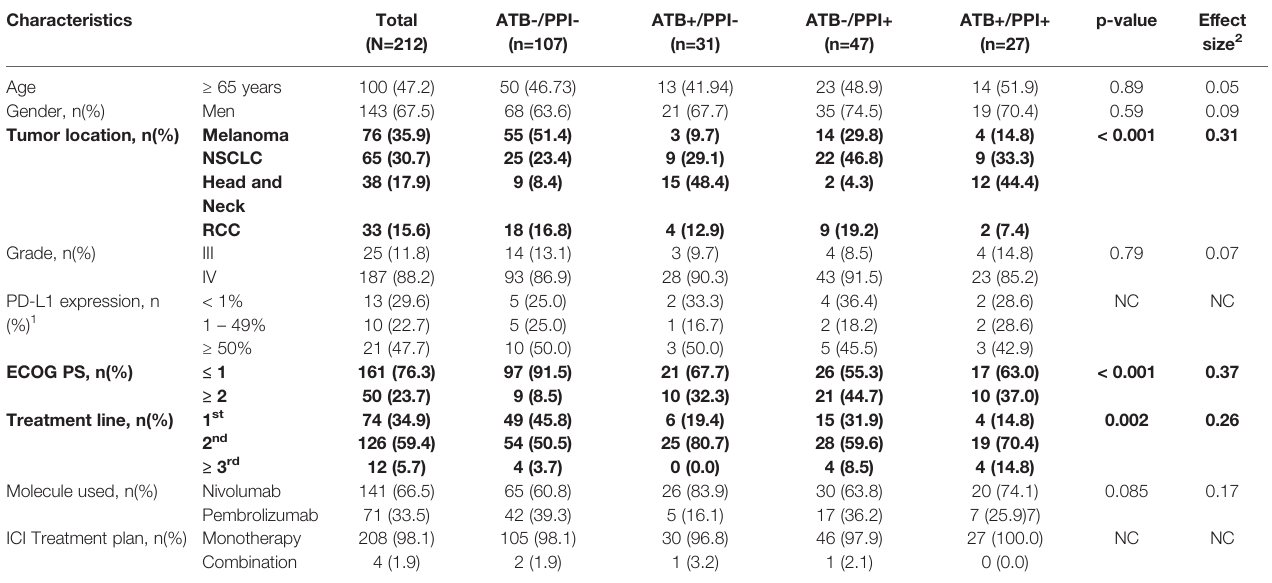
TABLE 1 | Characteristics of the study